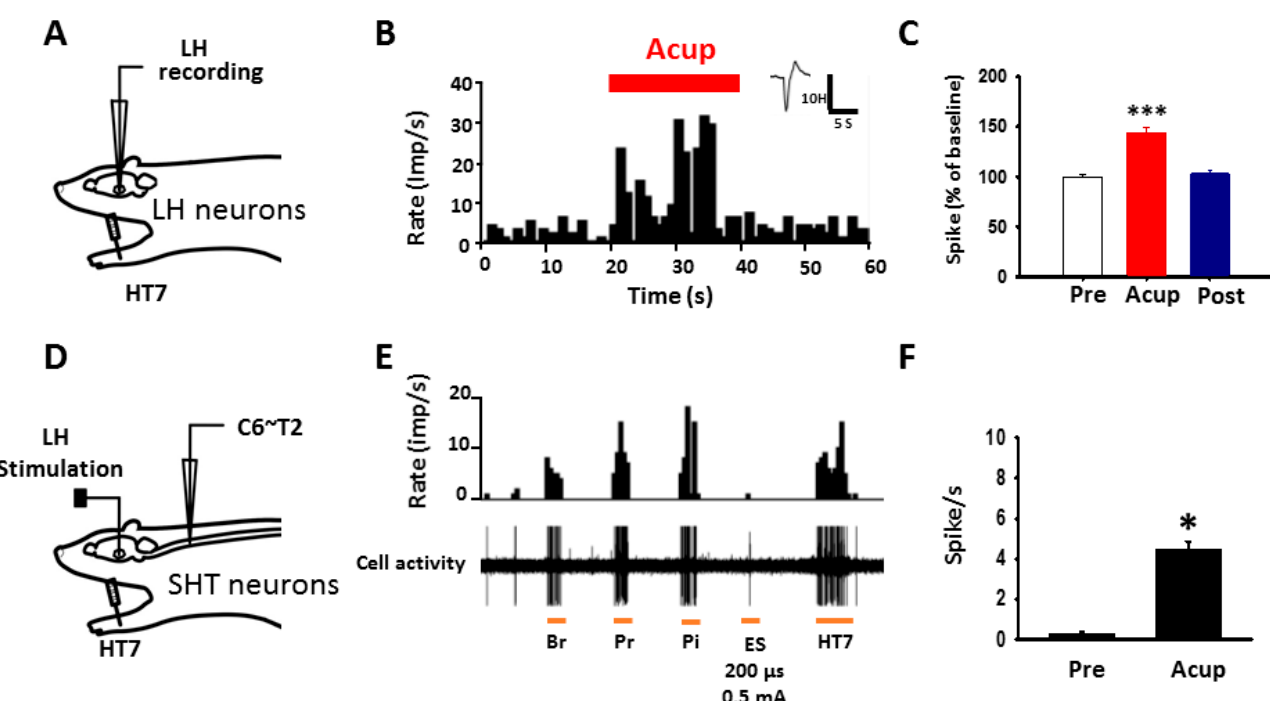
Figure 4. Excitation of LH or SHT neurons by acupuncture at HT7. ( A ) Schematic of in vivo extracellular recordings for LH neurons. ( B , C ) Effect of acupuncture at HT7 on single-unit activities of LH neurons. Peristimulus time histogram ( B ) and mean values of spikes before (Pre), during (Acup) and after (Post) acupuncture (expressed as percentage of pretreatment value, ( C ) *** p < 0.001 vs. Pre. n = 20. ( D ) Schematic of in vivo extracellular recordings for SHT neurons. ( E , F ) Effect of acupuncture at HT7 on single-unit activities of SHTN. Peristimulus time histogram ( E ) and mean values of spikes before (Pre) and during (Acup) acupuncture (expressed as percentage of pretreatment value, ( F ) * p < 0.05 vs. Pre. n = 10. Br, brush stimulation; Pr, pressure with a von Frey filament; Pi, pinch; Es, electric stimulation to LH; HT7, mechanical stimulation of needles inserted into HT7.